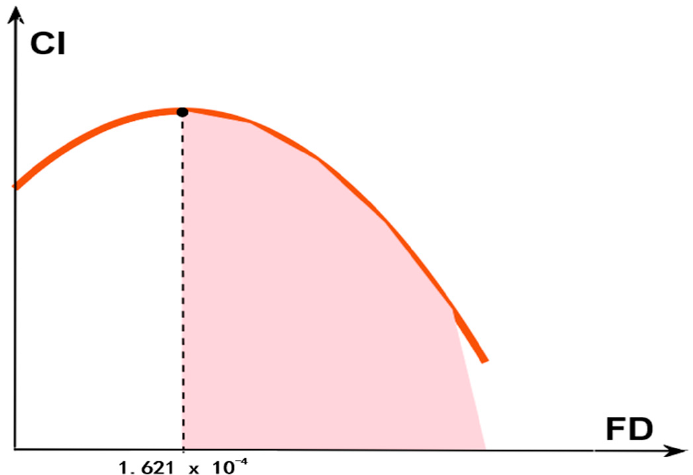
Figure 6. The inflection point of the inverted U-shaped relationship. According to the indexes of FD, of the 30 provinces from 2006 to 2019, the minimum value of FD is 0.0424 at Qinghai in 2006, greater than the inflection point 1.621 × 10 − 4 . It